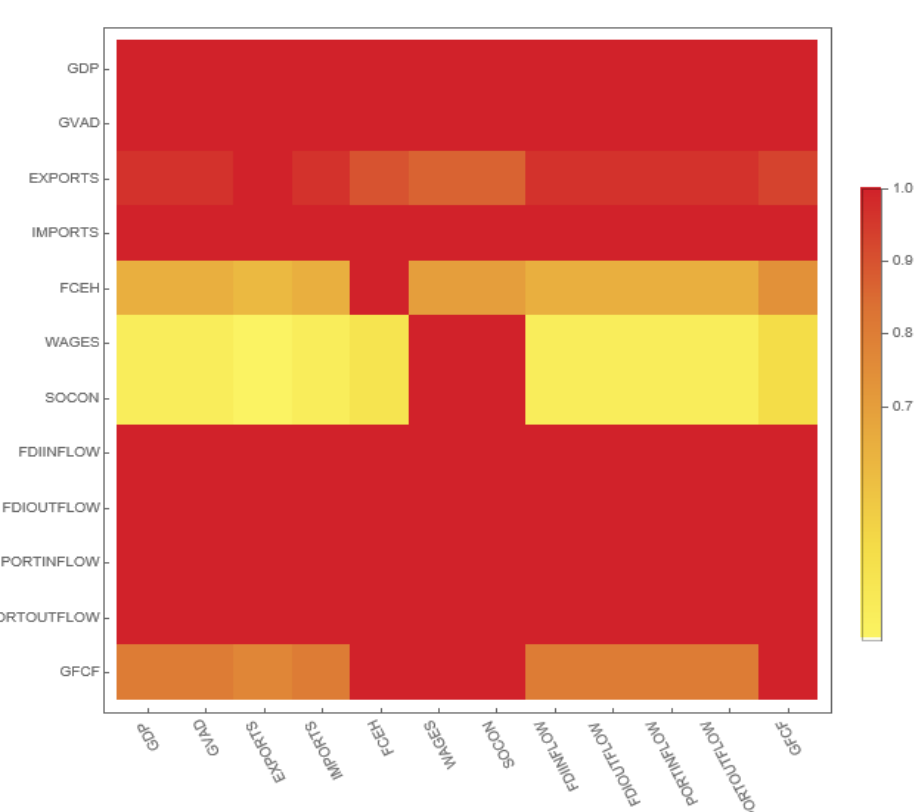
Figure 5. Heat map for c onditional probabilities of links.